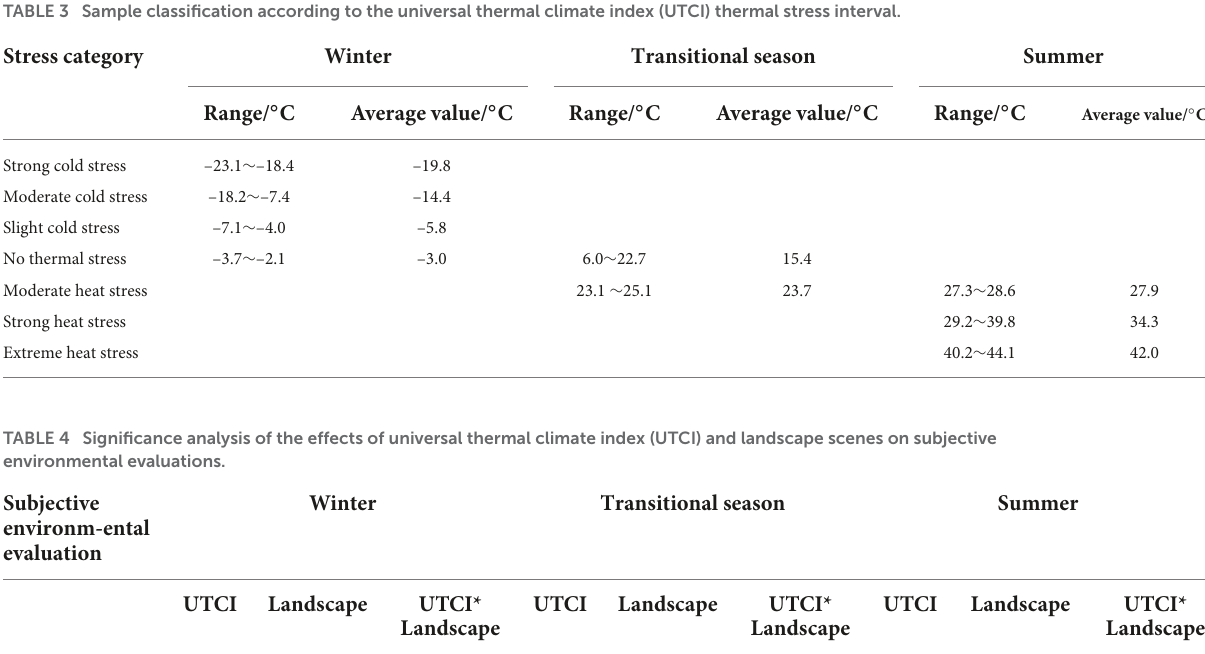
( Table 5 ) indicated that there was no difference between the TSV in the building and green landscapes in winter and summer ( P > 0.05), but both of their TSV values were significantly